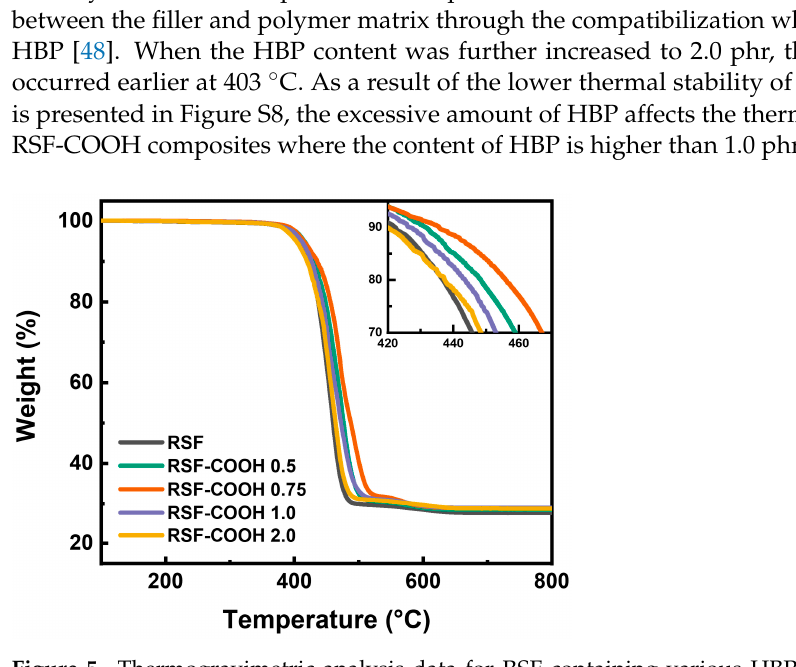
Figure 5. Thermogravimetric analysis data for RSF containing various HBP contents. Inset: A close- up of the 420–470 °C region.